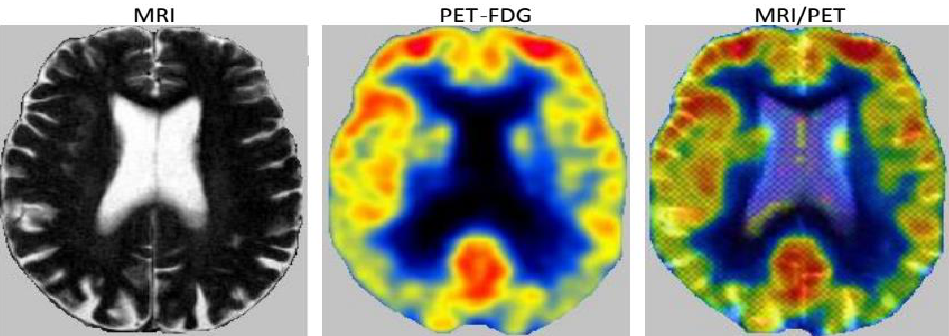
Figure 5. Example of anatomical and functional images of the same brain and the synthetic image resulting from the automatic segmentation based on the proposed multimodal fusion approach.